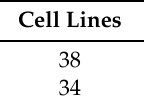
Table 1. Datasets used in the meta-analysis. The number of independent GEO entries (Series IDs, GSE) that met the criteria described under methods is shown (“Studies”). For each study, only those samples corresponding to normoxic and hypoxic conditions were retrieved ignoring any other treatment that the study could have included. The total number of samples meeting these criteria is shown (“Samples”). In those cases were a study included more than one cell line, different degrees of hypoxia or different exposure times, the samples were divided into subsets including a single level for each one of these variables. The total number of subsets generated is shown (“Subsets”). The column “Cell lines” indicates the number of different cell lines included in the dataset. The rows contain values corresponding to the dataset prior (“Initial”) and after (“Filtered”) filtering to remove outlier studies. Dataset Studies Samples Subsets Cell Lines Initial 46 472 81 38 Filtered 43